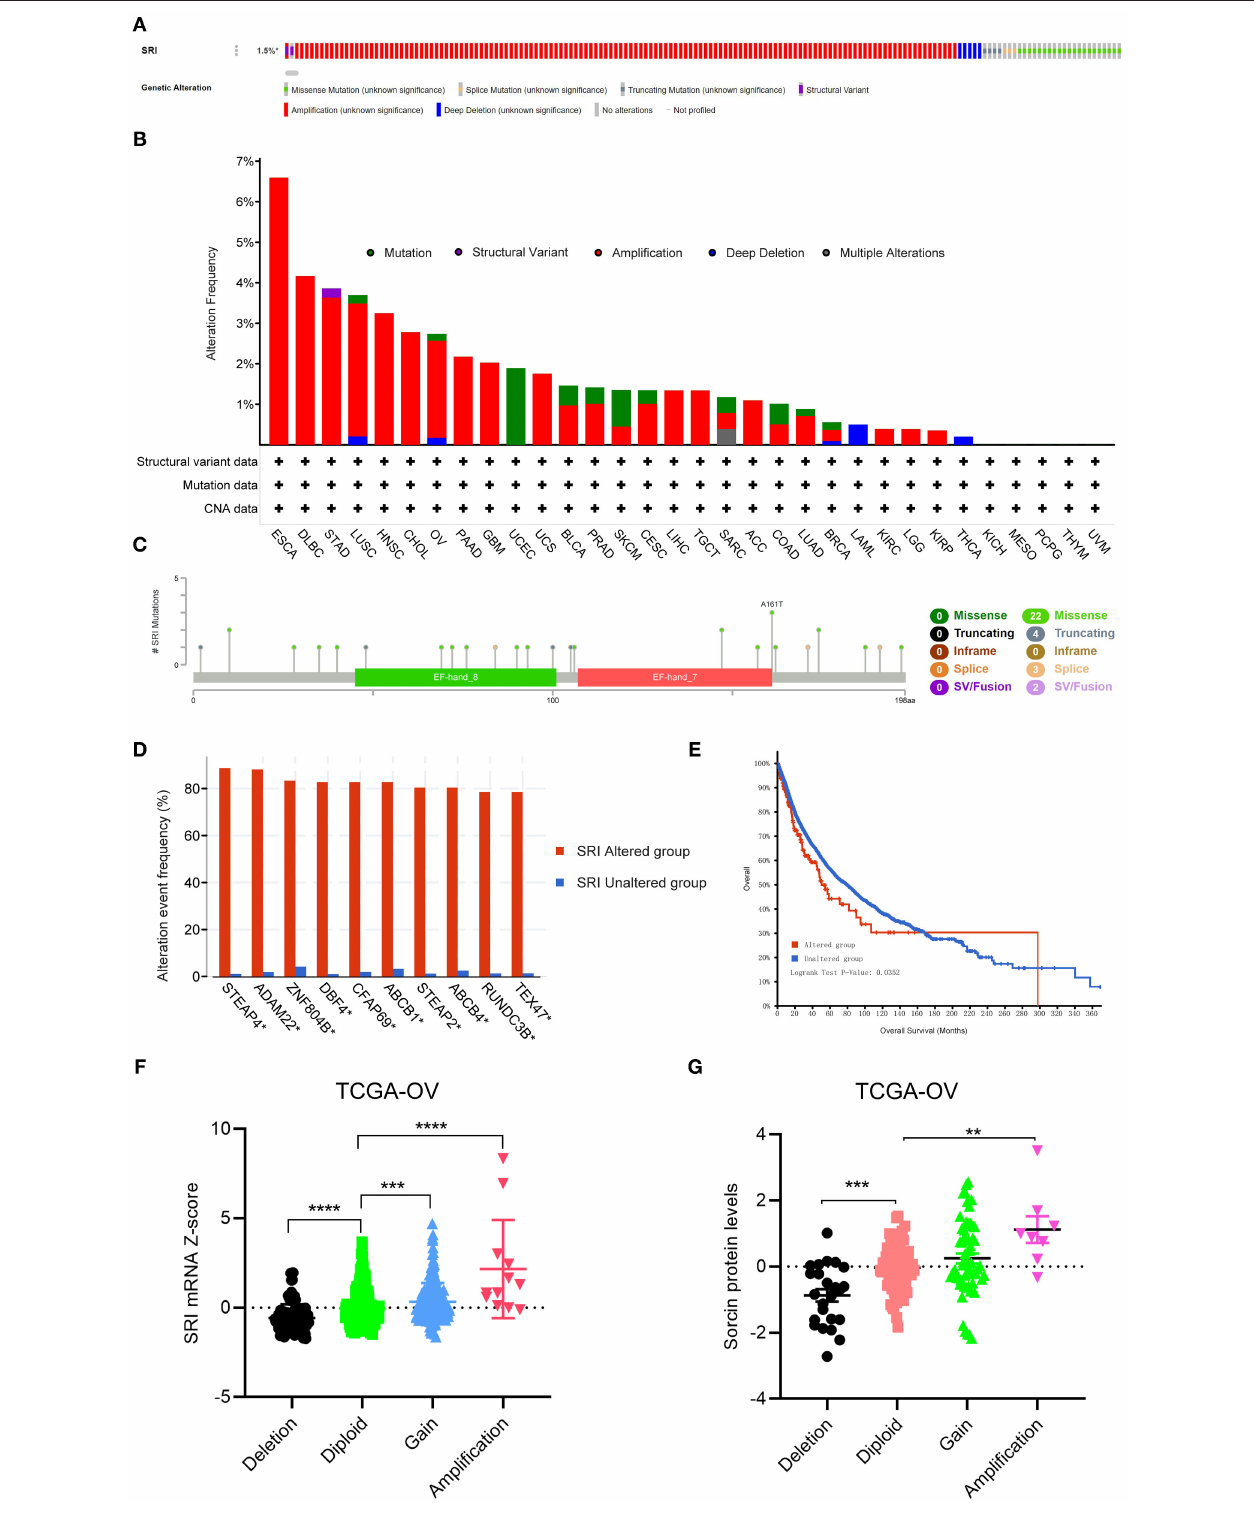
FIGURE 6 | The genetic alterations of SRI in TCGA pan-cancer. (A) OncoPrint summary of the alterations on SRI in TCGA pan-cancer datasets. (B) Summary of the alteration frequency of SRI derived from structural variant, mutations, and copy-number alterations data in TCGA pan-cancer datasets. (C) The mutation